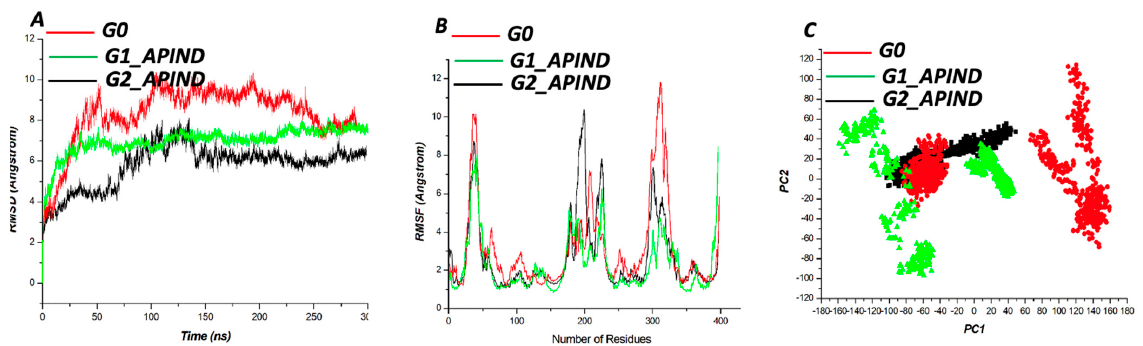
Figure 3. Backbone RMSDs are depicted as a function of time for the wildtype protein (G0) and bound variants (G1 and G2) ( A ). C α fluctuation for the wildtype protein (G0) and bound variants (G1 and G2) ( B ). PCA scatter plots depicting a distinct separation of motions for the wildtype protein (G0) and bound variants (G1 and G2) ( C ).